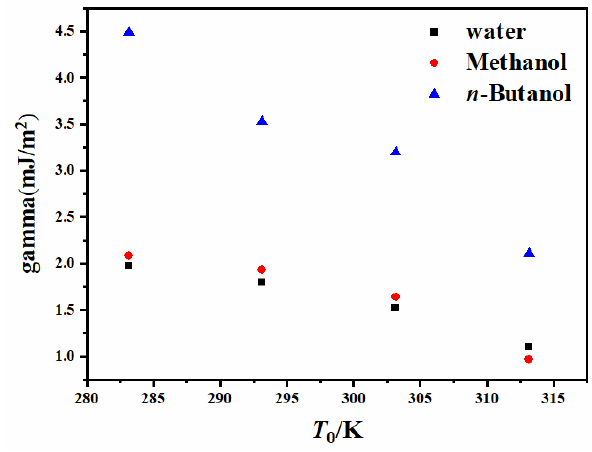
Figure 6. Relationship between the solid–liquid interfacial tension ( γ ) and saturation temperature.